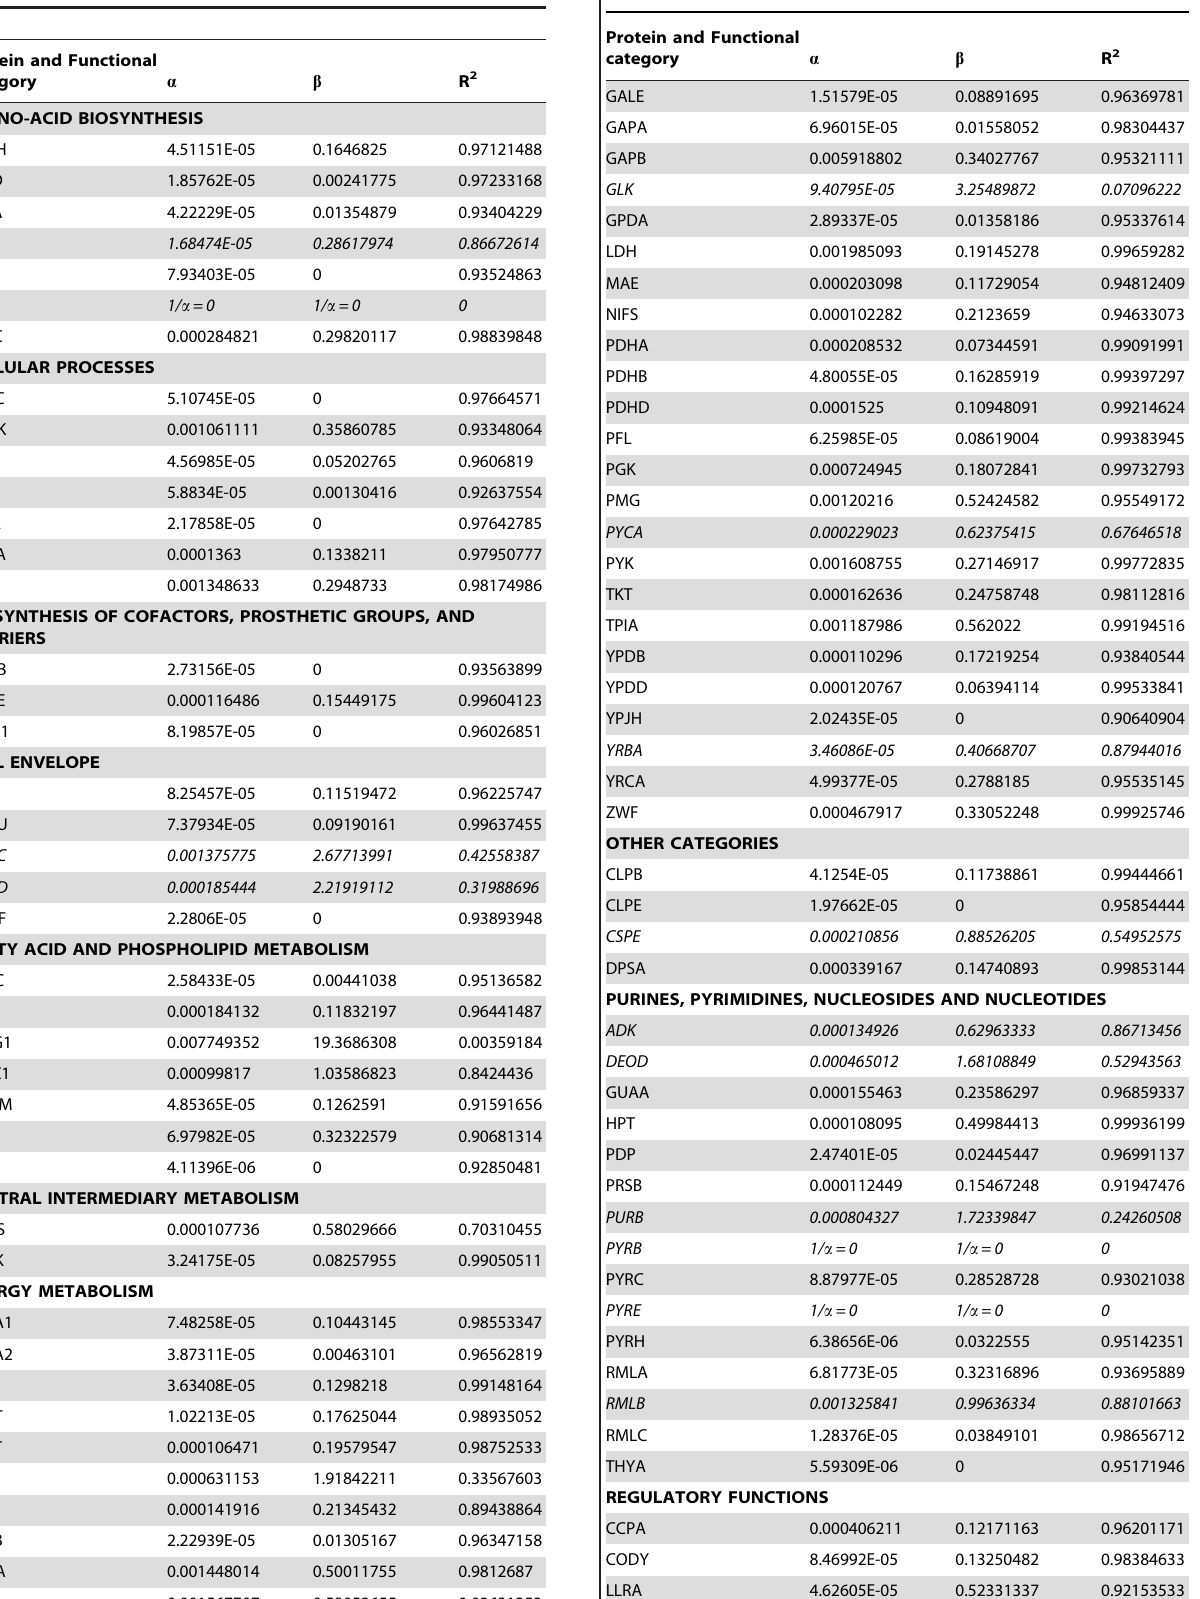
Table 3. Modeling of the mRNA/protein ratios by a linear relation of m 2 / a + b / a